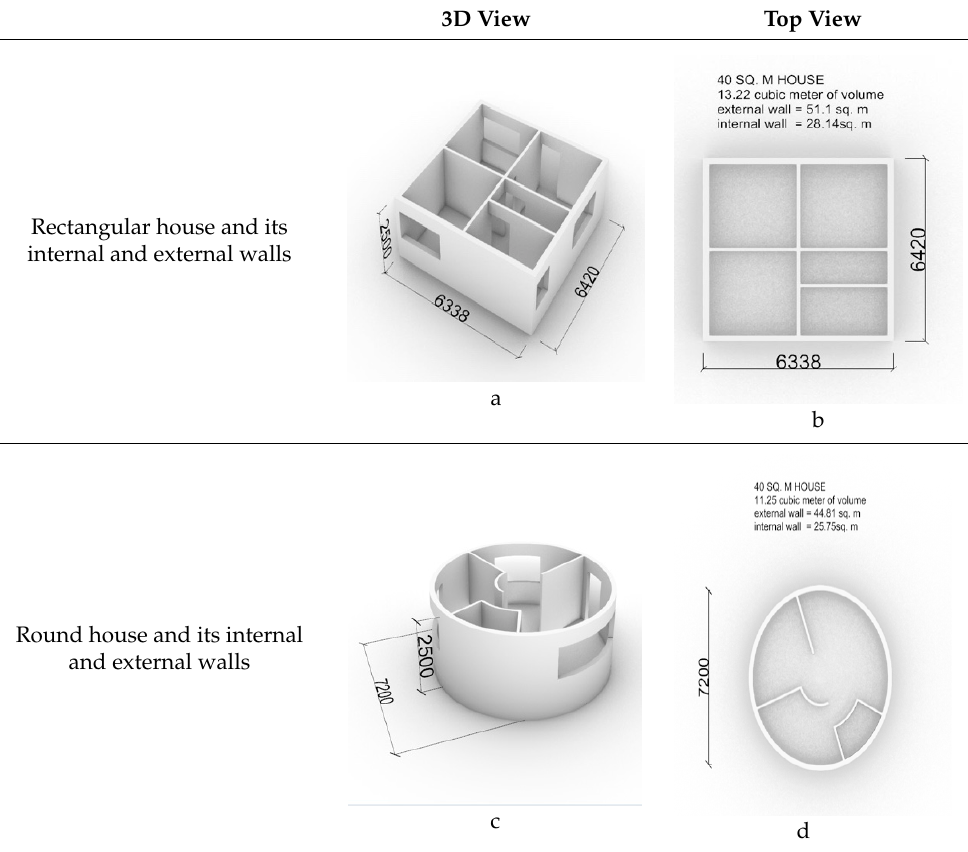
Table A1. The architectural 3D model of the cases.